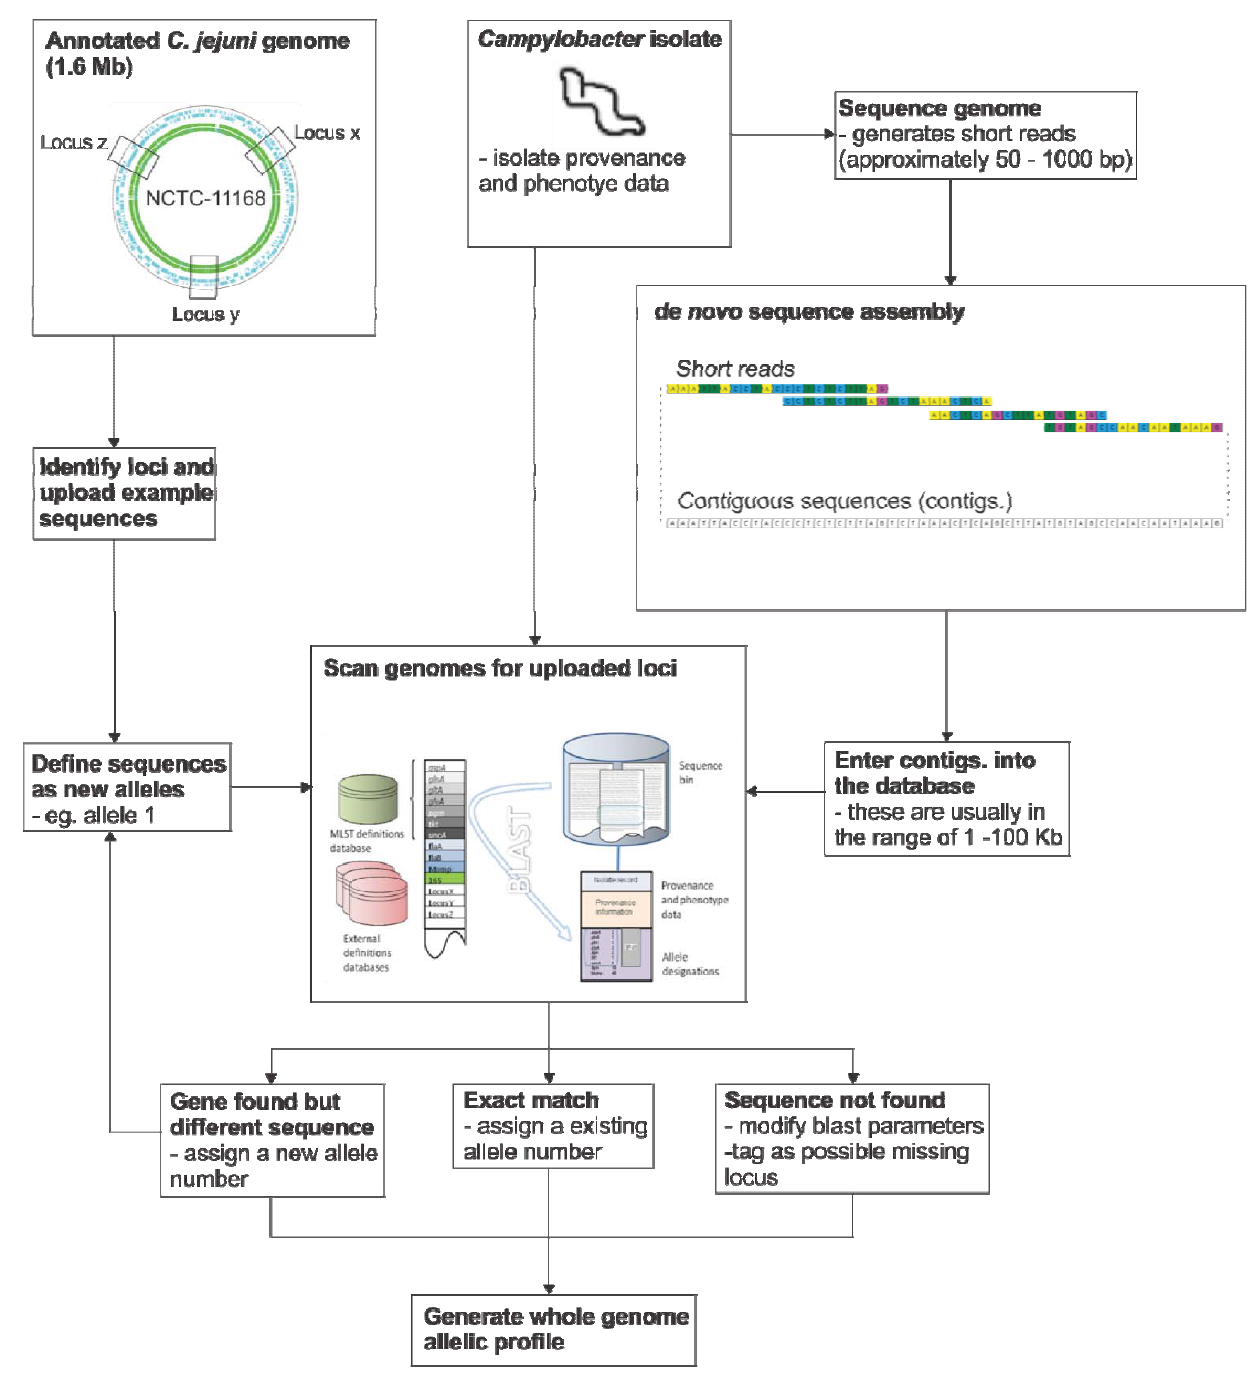
Figure 2. Schematic diagram of the gene-by-gene analysis